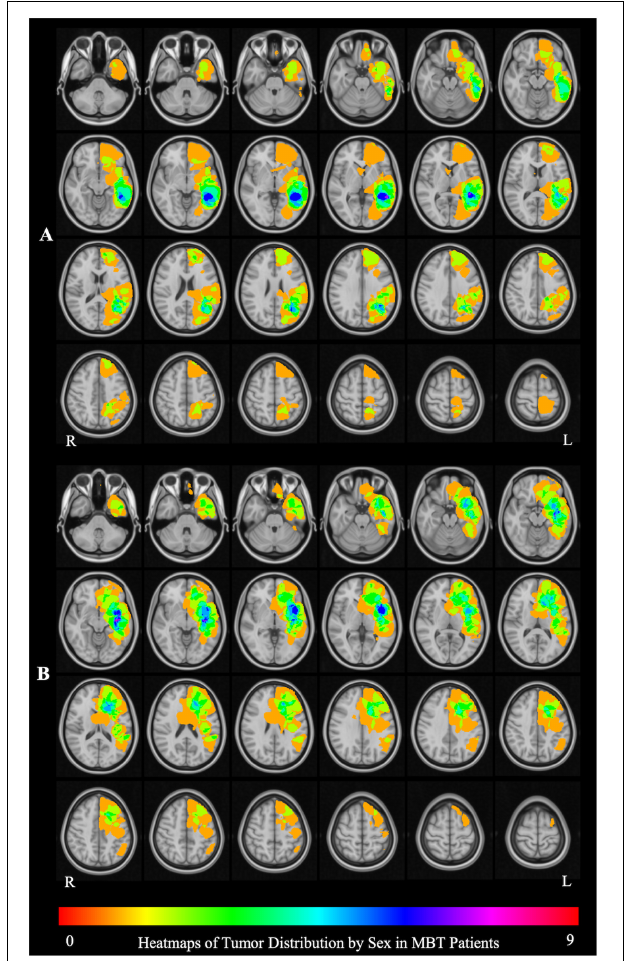
FIGURE 1 | Brain tumor location by sex. (A) The aggregate map of brain tumor location in male patients. The peak tumor locations are in in the medial aspect of the left middle temporal [9/25 patients; peak coordinate (x, y, z): –34, –15, –10] and inferior frontal (6/25 patients; peak coordinate: –28, 25, 0) cortex. (B) The aggregate map of tumor location in female patients. The peak tumor location is in the lateral aspect of the left posterior middle temporal gyrus (MTG) (7/22 patients; peak coordinate: –52, –42, 1). The heat maps represent the number of patients with a tumor infiltrating the brain at each